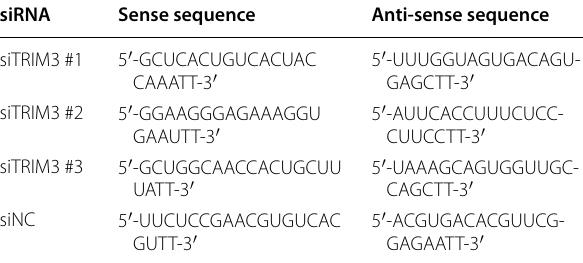
Table 1 Small interfering RNA (siRNA) sequences that tar- get tripartite motif-containing 3 (siTRIM3) and negative control siRNA